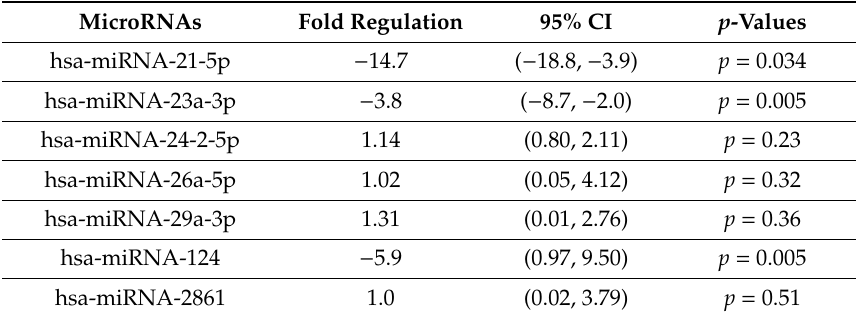
Table 3. Di ff erential expression pattern of microRNAs linked to bone metabolism in the serum of end-stage renal disease (ESRD) patients compared